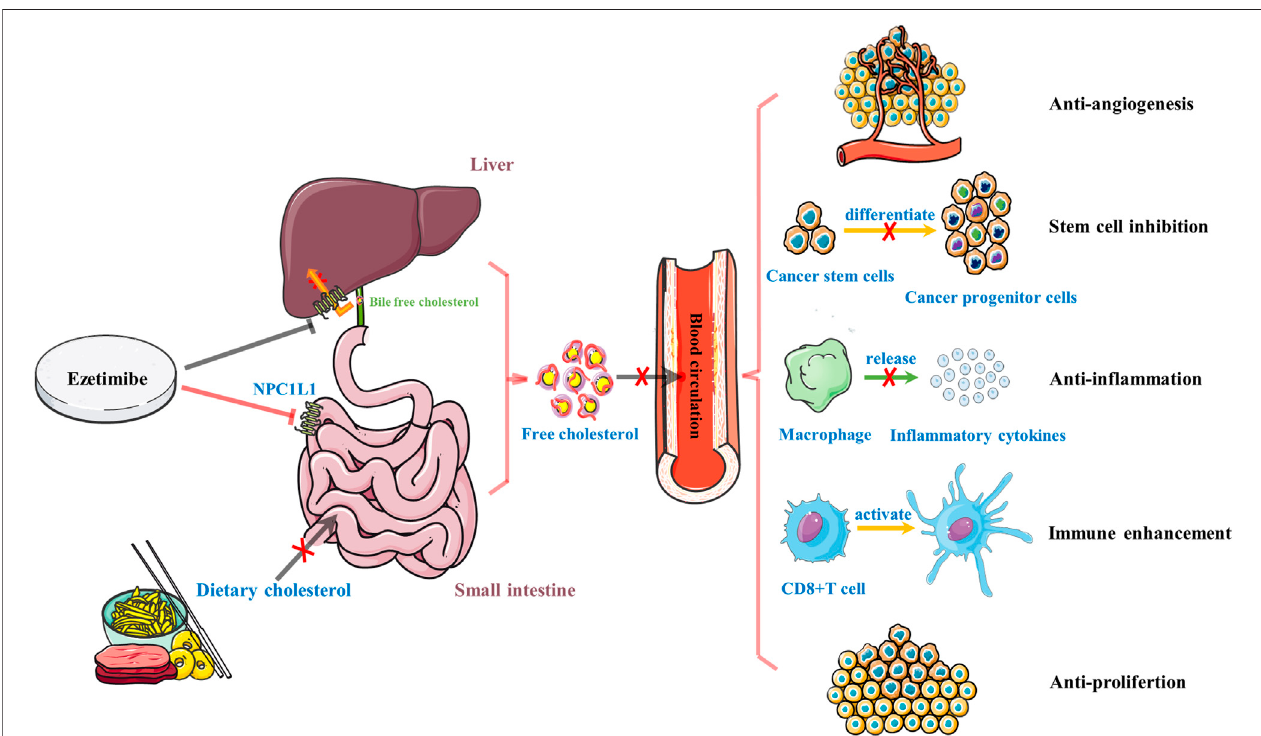
FIGURE 1 | A brief summary of the role of ezetimibe in anti-cancer. Ezetimibe reduces high levels of circulating cholesterol by inhibiting the absorption of dietary cholesterol in the small intestine and biliary free cholesterol back into the liver and exhibits its anti-cancer ability through fi ve primary mechanisms, including anti- angiogenesis, stem cell inhibition, anti-in fl ammation, immune enhancement, and anti-proliferation.